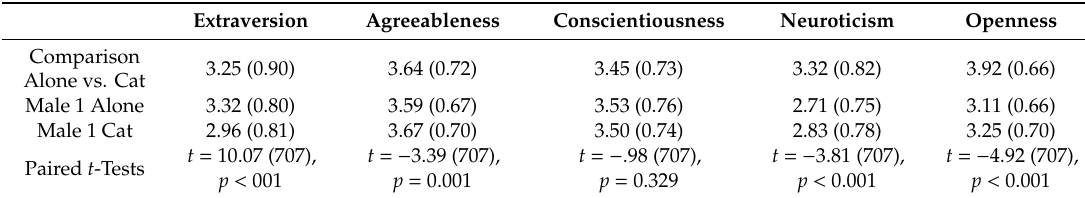
Table 2. Survey / Male 1 Big Five